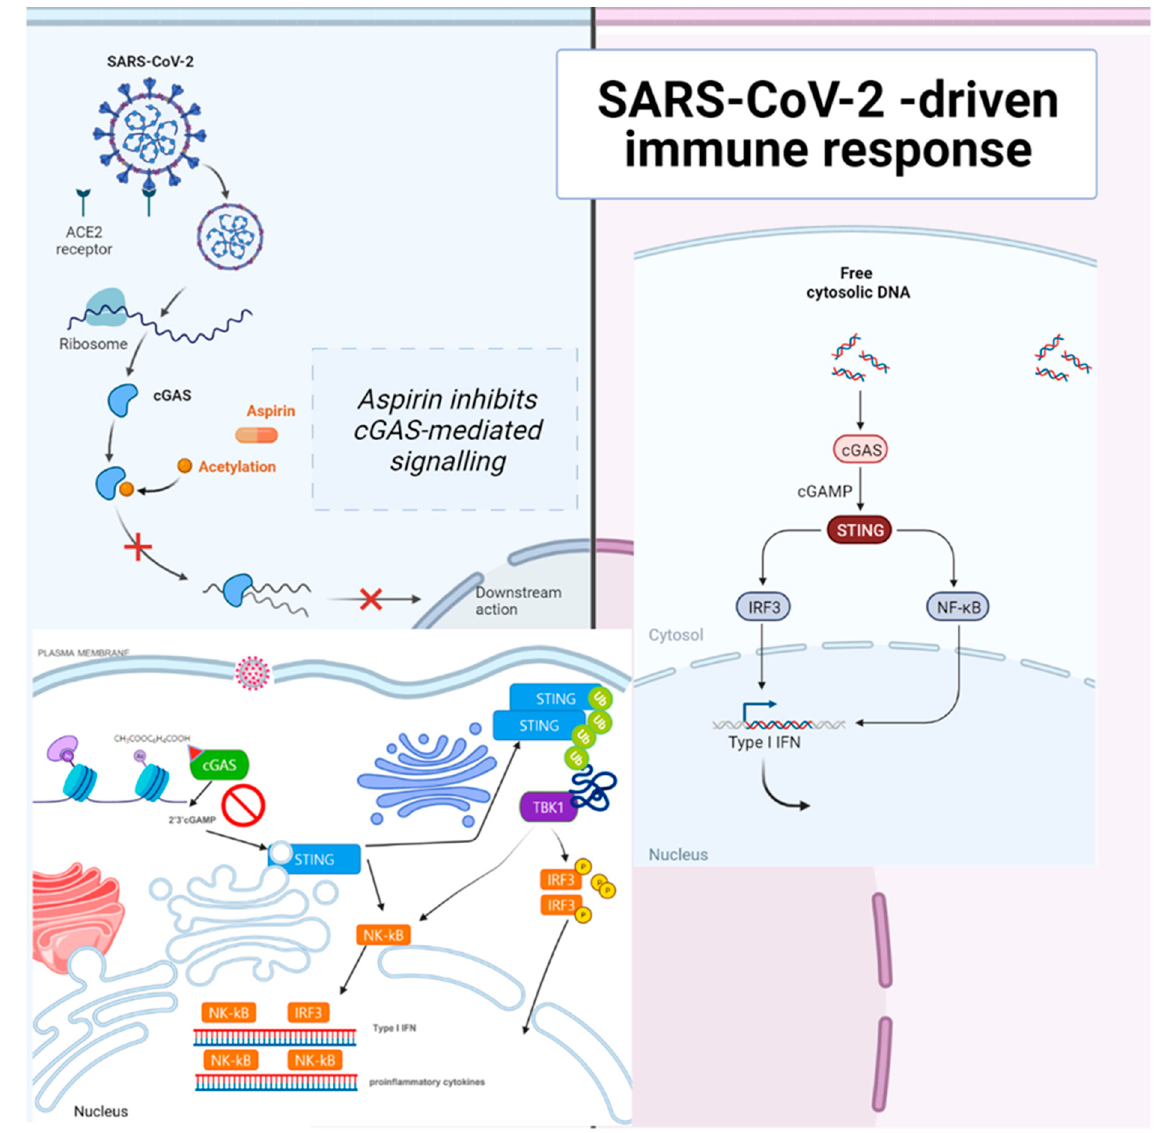
axis through the inhibition of cGAS [49]. The COVID-19 treatment mechanism of aspirin and dapsone is through SAMHD1 tetramerization and the cGAS–STING signaling path- way (Figure 3).